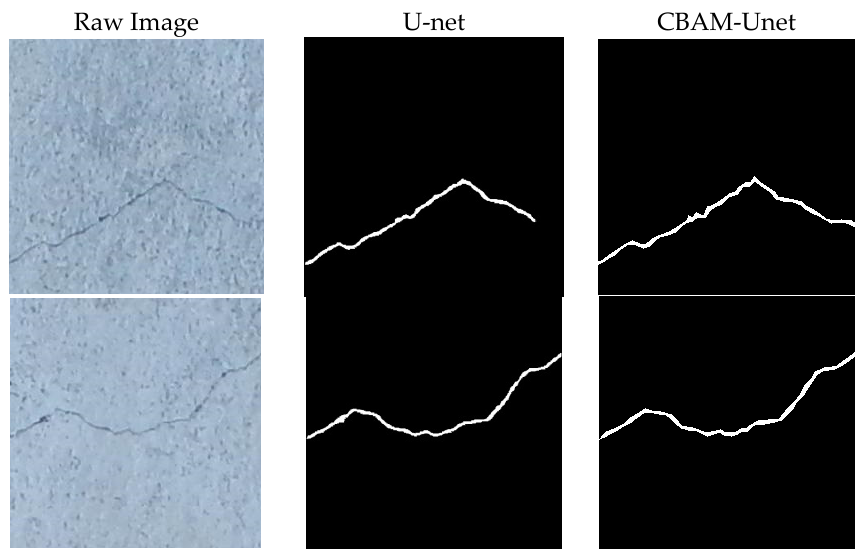
Figure 14. Results of the two methods in dark conditions.